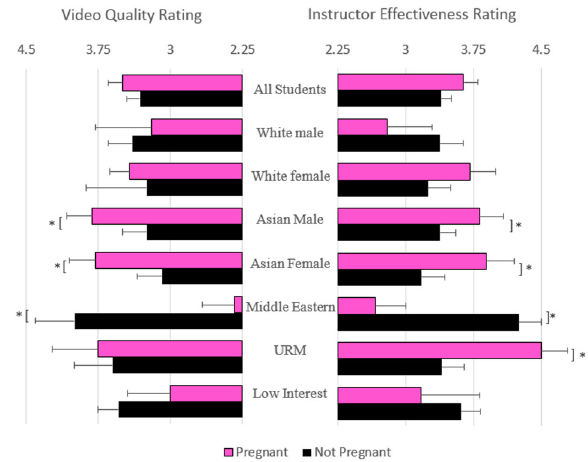
Fig. 5 The mean rating scores as reported by students of video quality and instructor effectiveness awarded to the actress instructor by student race, gender, and level of interest in the class. Error bars show standard error and asterisks indicate statistical signi fi cance ( p <